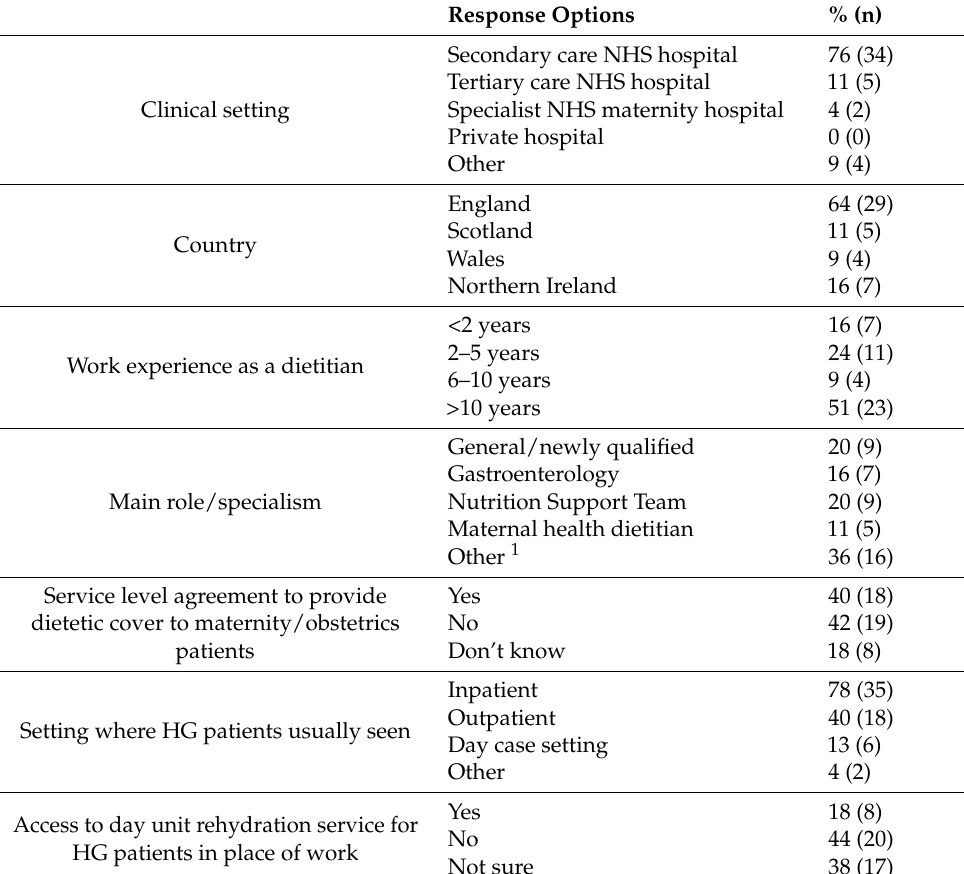
Table 1. Respondent